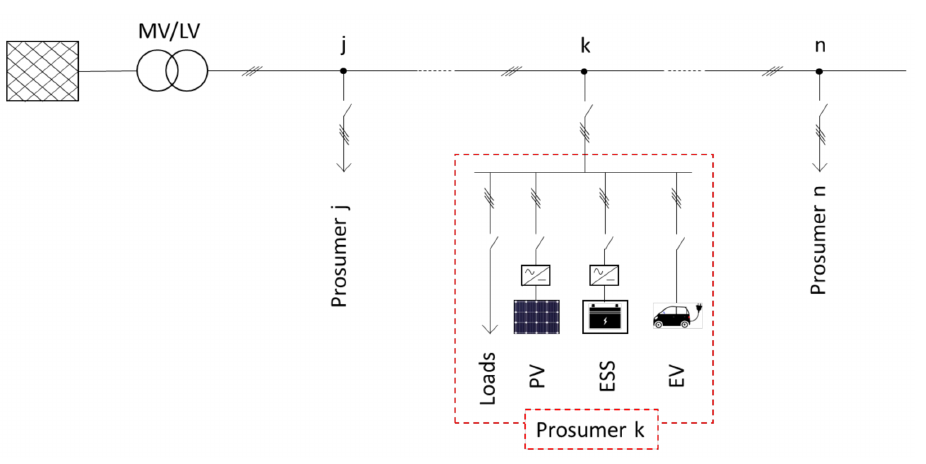
Figure 1. Generic structure of prosumer hybrid installation connected to the LV